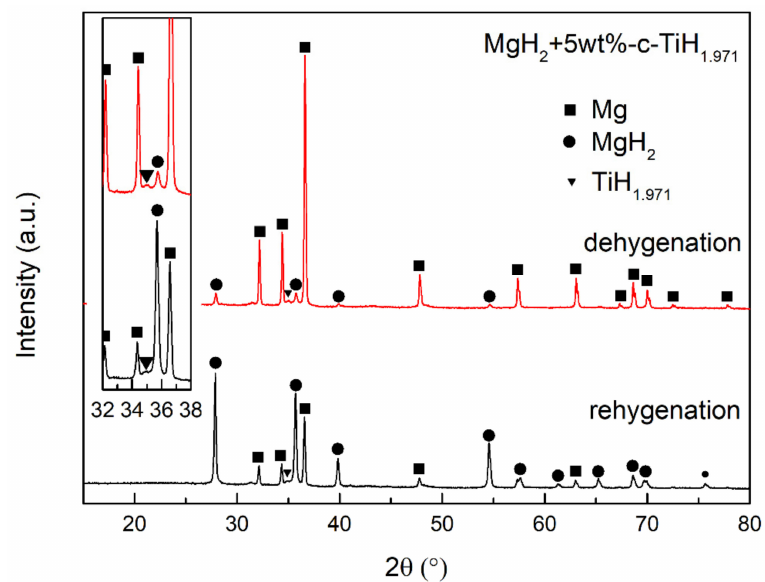
Figure 8. XRD patterns of dehydrogenated and rehydrogenated MgH 2 / TiH 1.971